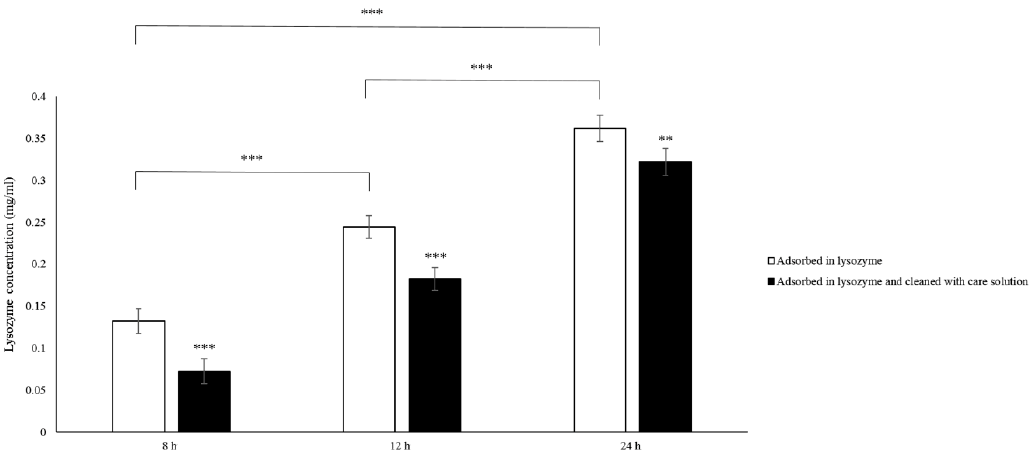
Figure 4. Lysozyme deposition with and without being cleaned by the γ -PGA-containing care solution. The deposited lysozyme concentrations are measured directly after the Etafilcon-A lenses are placed in 1.9 mg / mL lysozyme solution for 8, 16, or 24 h (white bars), or after being cleaned by γ -PGA-containing care solution (black bars). ** p < 0.01 and *** p < 0.001.